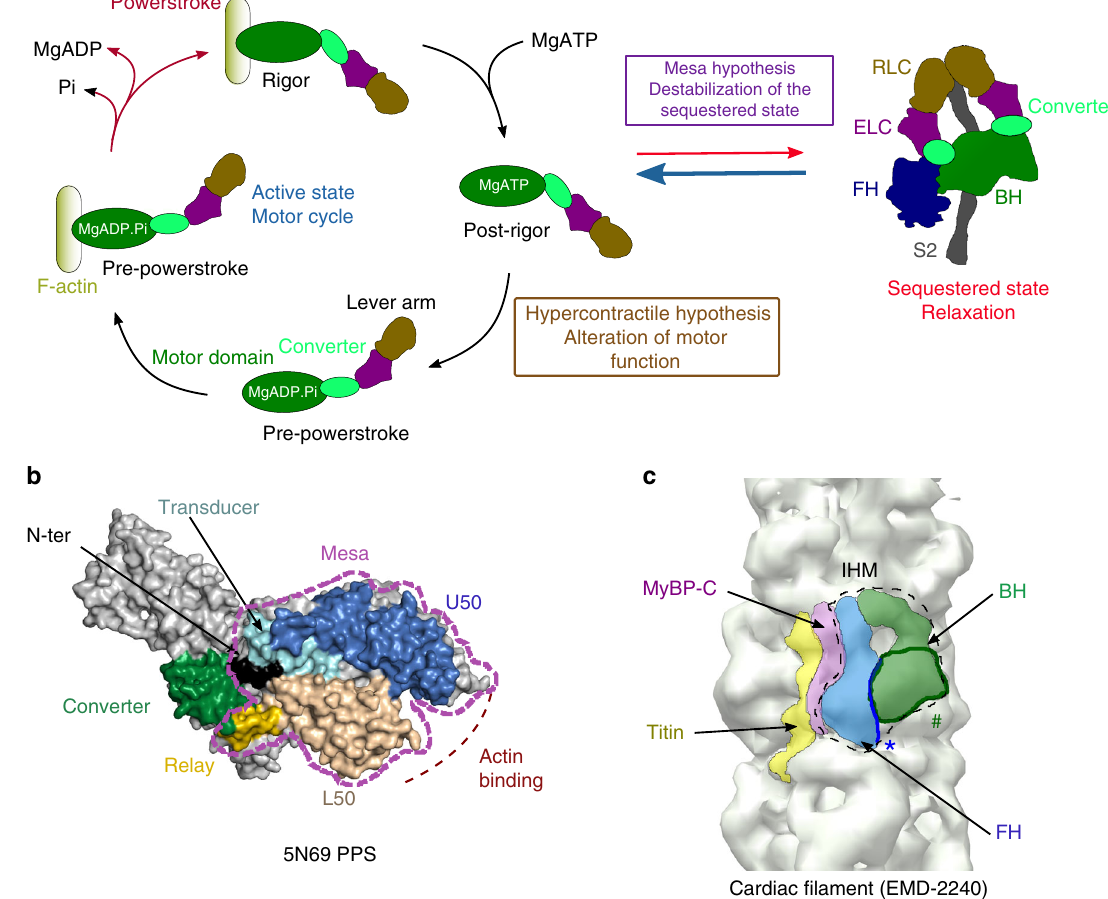
Fig. 1 Myosin mesa and sequestered state. a Schematic representation of the motor cycle and the regulation of the β -cardiac myosin activity. On the left, when the motor detaches from the track upon ATP binding, the motor adopts the post-rigor (PR) state in which the lever arm is down and the motor has poor af fi nity for F-actin. During the recovery stroke, repriming of the lever arm leads to the pre-powerstroke (PPS) state in which hydrolysis can occur. The swing of the lever arm (powerstroke) upon reattachment of the motor to F-actin is coupled with the release of hydrolysis products. The nucletotide-free or rigor state has the highest af fi nity for F-actin. On the right, scheme of the sequestered state that is formed during relaxation. According to the mesa hypothesis, HCM mutations disrupt the sequestered state, increasing the number of myosin heads available to produce force. According to the Hypercontractile hypothesis, HCM mutations alter the myosin motor activity. b The mesa (purple dashed lines) is a long and fl at surface of the myosin head composed of several myosin subdomains conserved in myosin IIs. c Electron density map of the human cardiac fi lament obtained from negative staining 23 (EMDB code EMD-2240). In the relaxed state, interactions between the blocked head (BH) and the free head (FH) of the myosin 2 dimer stabilize an asymmetric con fi guration. Extra densities of the fi lament correspond to other components of the thick fi lament, the cardiac myosin MyBP-C, and titin. Location of the mesa for each head indicates that the FH mesa (*) interacts with the BH while the BH mesa (#) is buried and interacts with components of the thick fi